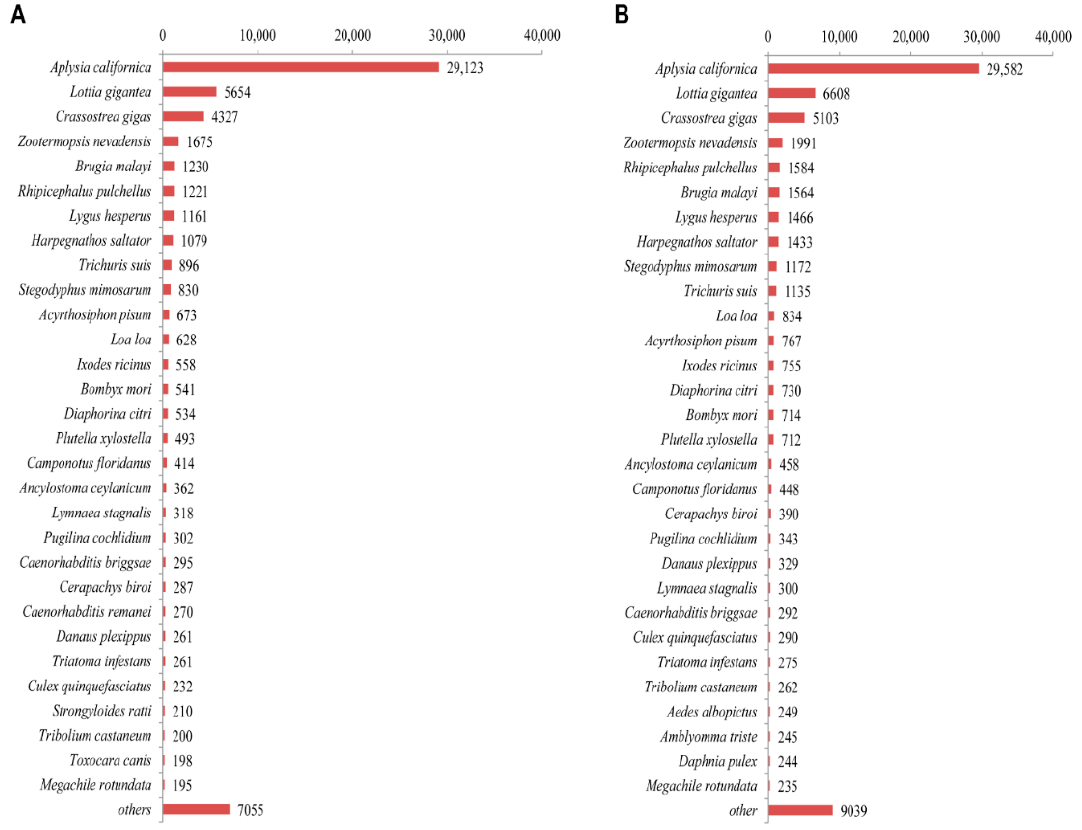
Figure 6. PANM-DB based top-hit species classification for ( A ) A. chejuensis ; and ( B ) A. quelpartensis using BLASTX analysis.